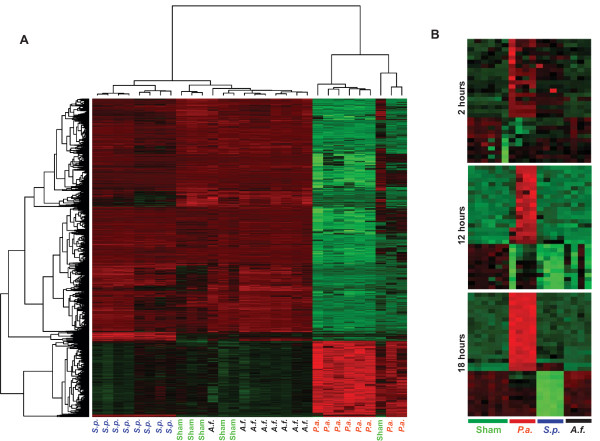
Early development of infection-specific transcription profiles. (A) Six hours after challenge with P. aeruginosa, S. pneumoniae, A. fumigatus or PBS (sham), lungs were removed and submitted to microarray analysis, and a heatmap was generated with green indicating decreased gene expression and red indicating increased gene expression. At this time, 4,274 genes were highly differentially expressed (FDR< 1 × 10-7), and by unsupervised clustering, most samples self-segregated by challenge. (N = 6 sham infected mice, 8 mice for each infection.) (B) The 30 genes that were most strongly differentially expressed at 18 h after infection were examined at earlier time points, demonstrating the increasing clarity of the differential pattern. (N = 6 sham infected mice, 4 mice for each infection.)